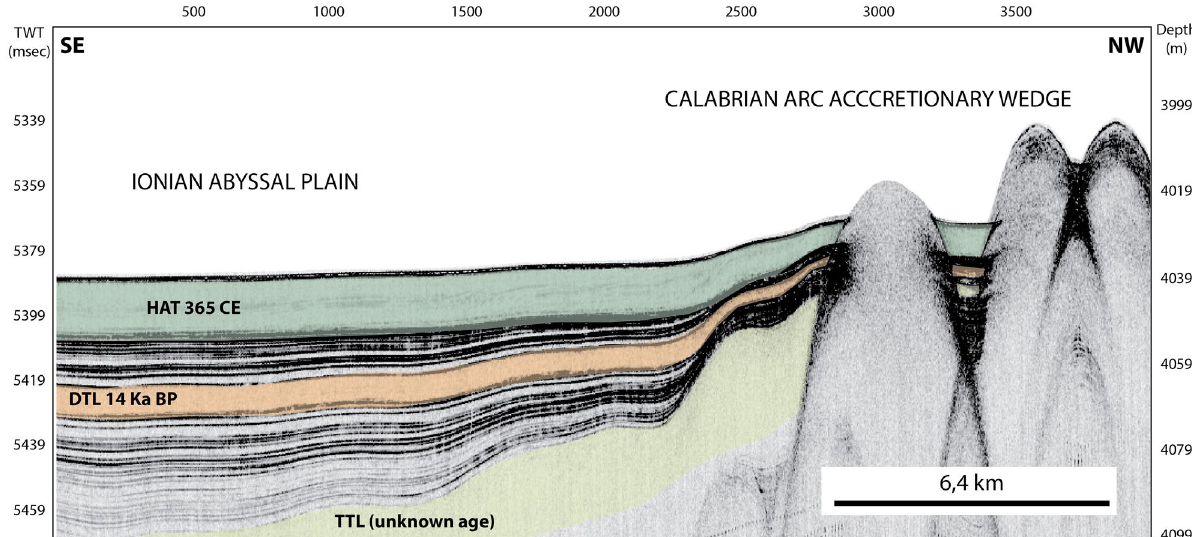
Figure 11. Chirp profile across the deformation front of the Calabrian Arc accretionary wedge (see location in Fig. 1). Three similar megaturbidites revealed by CHIRP data. The HAT (Homogenite-Augias Turbidite 3 ), the DTL (Deep Transparent Layer 26 ) and TTL (Thick Transparent Layer 26 ) megaturbidites are highlighted in the profile by different colors (dark green, orange and light green, respectively). The low reflectivity seismic facies of these megabed in the Chirp profile is related to the upper rather homogeneous part of the megabed. The DTL composition suggests a similar source region as the HAT megaturbidite and an age of about 14 ka 3 . The age